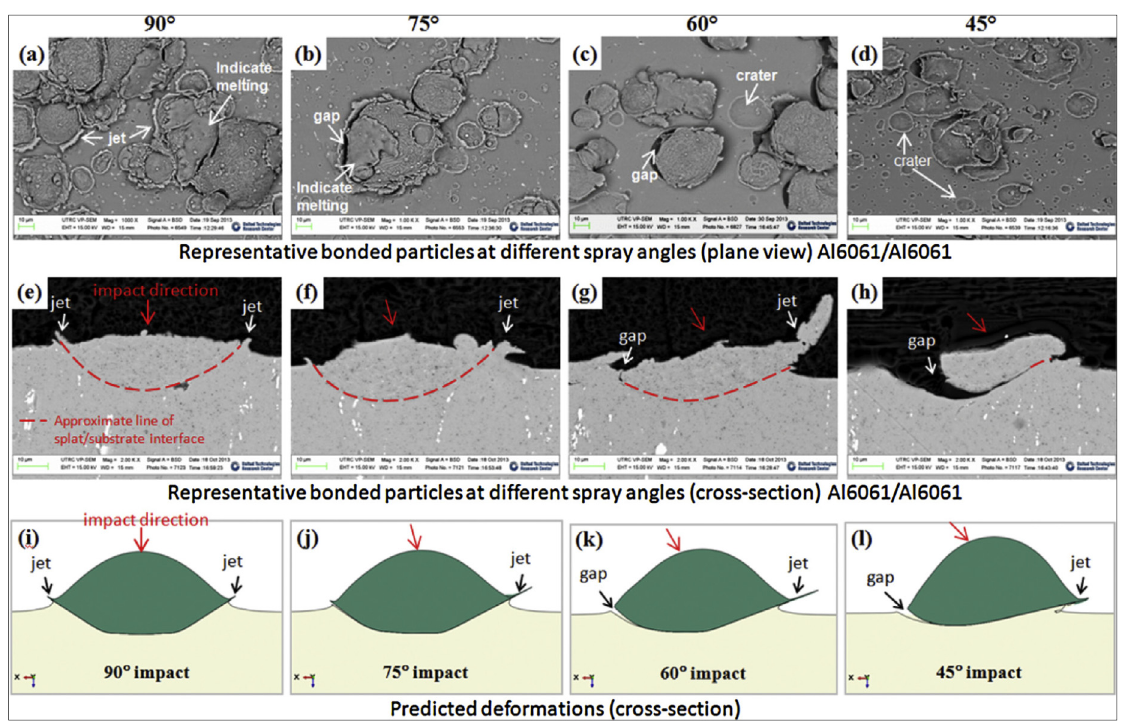
Figure 10. Effect of spray angles on bonded particles and their corresponding deformation [43].